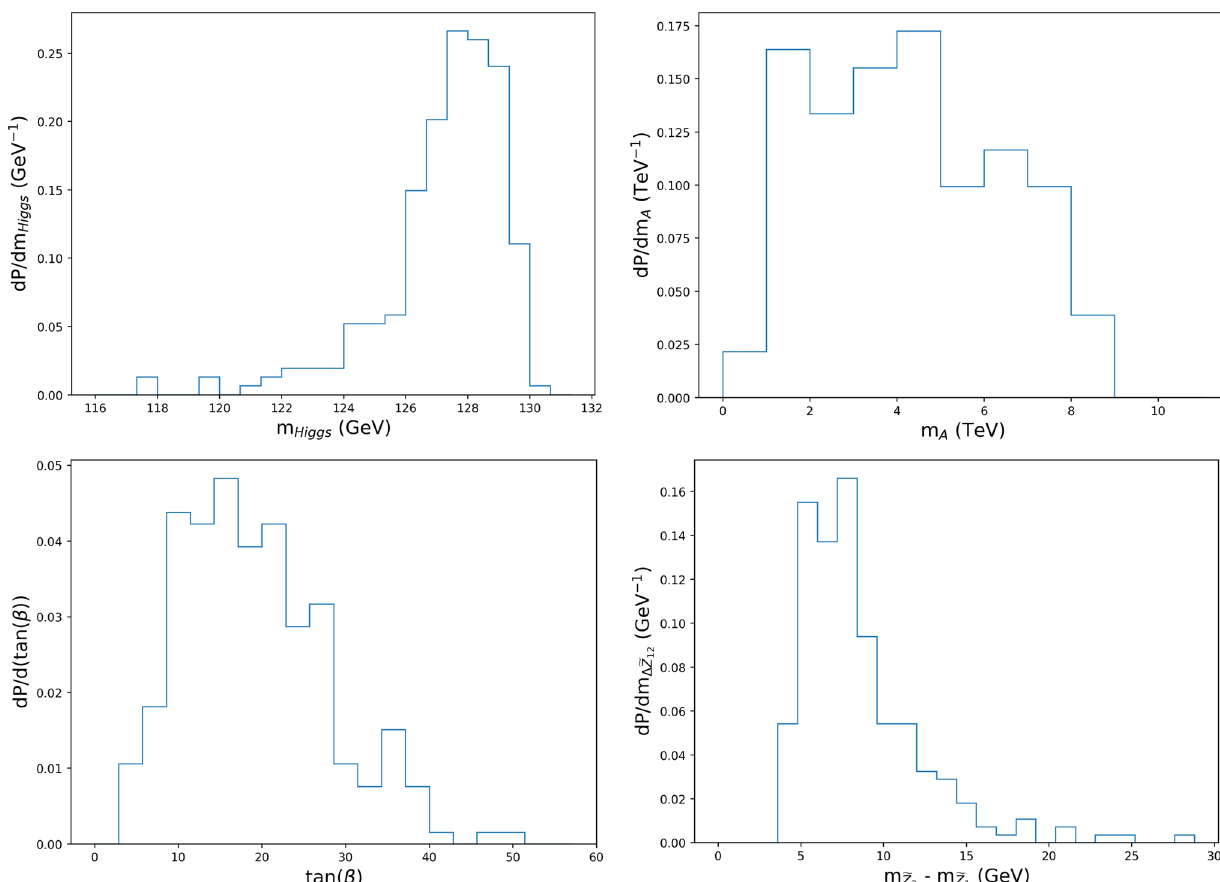
Fig. 6 Distribution of Higgs and EWino sector from a subset of landscape vacua with NUHM3 model as low energy EFT and an n = 1 statistical draw. We show distributions in a m h , b ) m A , c ) tan β and d ) m ˜ χ 0